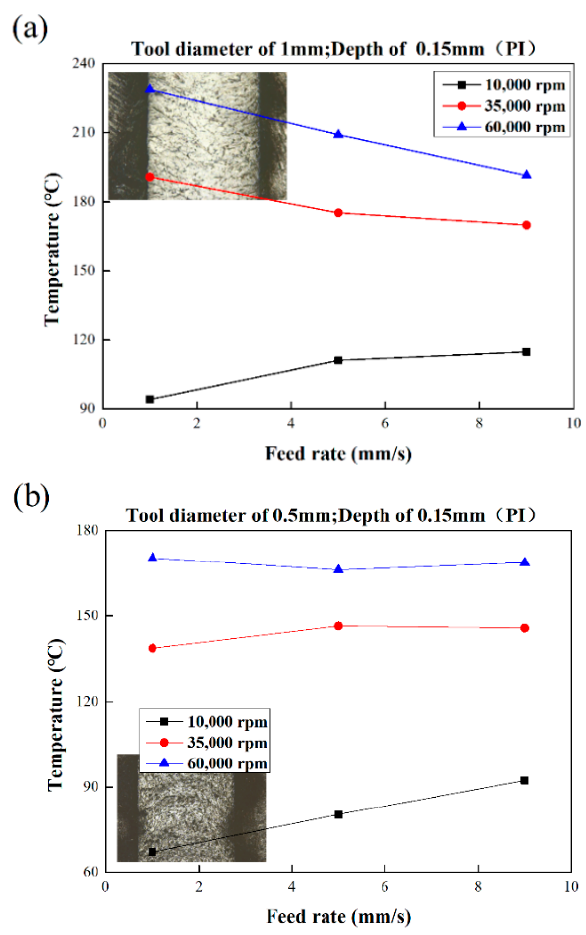
Figure 6. Bottom morphology of PI at various process parameters: ( a ) tool diameter 1 mm; ( b ) tool diameter 0.5 mm.